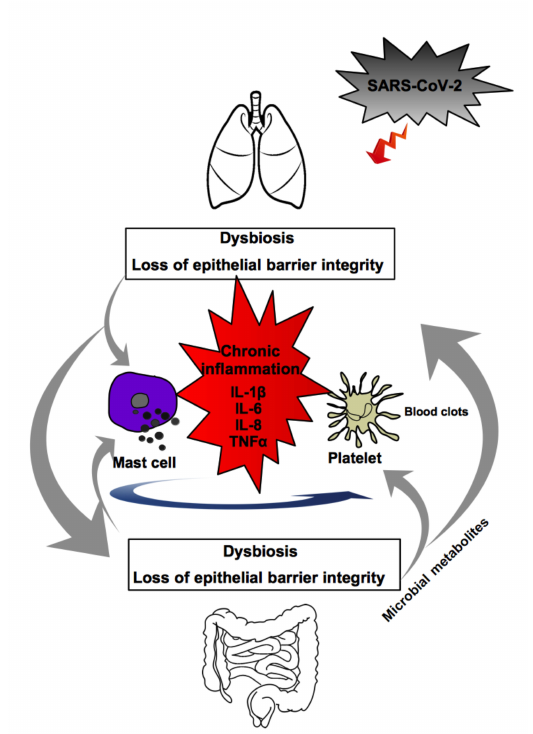
Figure 2. Drawing illustrating the crosstalk between the various players discussed in the paper. In the elderly subject there is a state of fragility of the lung and intestinal microbiota, with loss of the integrity of the epithelial barriers, and chronic silent inflammatory state. Activated mast cells produce a wide variety of cytokines, chemokines and other inflammatory mediators that extensively influence and condition the gut and lung microbiota composition in a vicious cycle; these mediators also affect platelets which, in turn, are affected by microbial